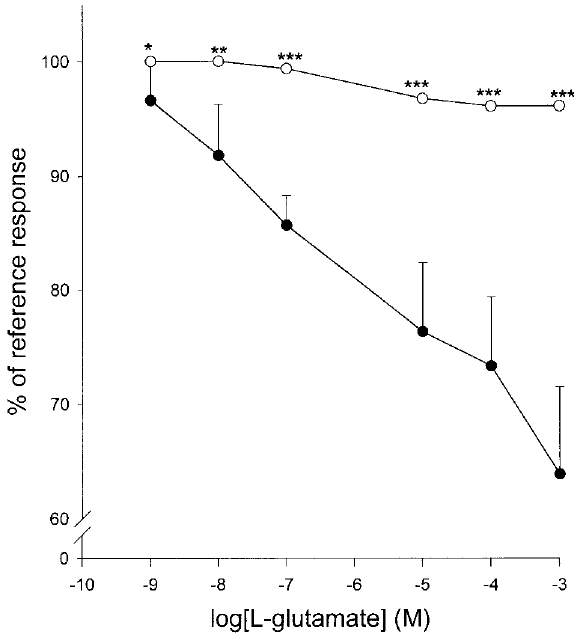
FIG. 5. The effect of L -glutamate ( d ), AMPA ( s ), kainic acid ( h ), NMDA ( j ) and NMDA in magnesium-free medium ( m ). The responses are mean ±SE; n = 11 for L -glutamate, and n = 5 for each other agonist. The responses are plotted as a percentage of the reference response before the exposure to agonist.